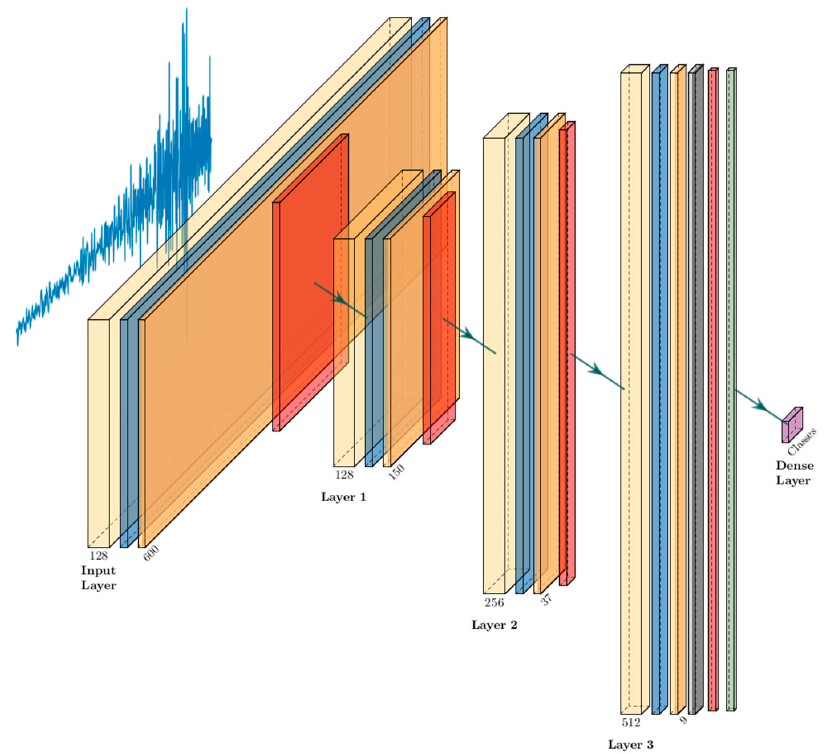
Figure 4. CNN architecture design with the colored layers. Yellow: convolution 1D; blue: batch normalization; orange: activation (ReLu); red: MaxPooling1D; gray: dropout (50%); light green: Lambda (mean); and purple: dense (softmax).